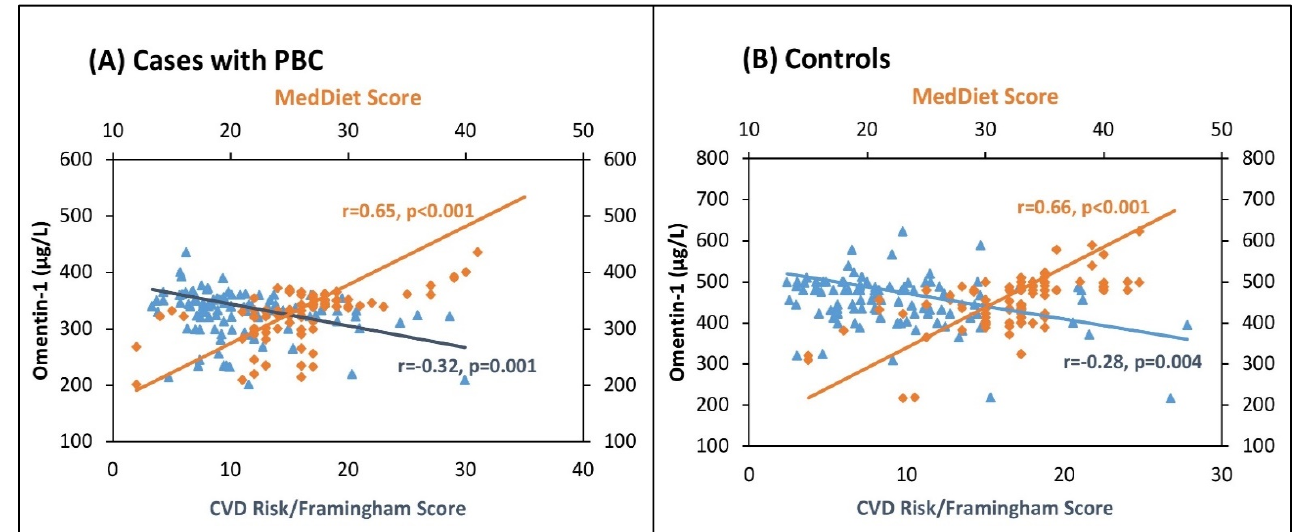
Figure 2. Association of serum omentin-1 with MedDiet Score and cardiovascular risk in 103 cases with postmenopausal breast cancer ( A ) and in 103 control participants ( B ).